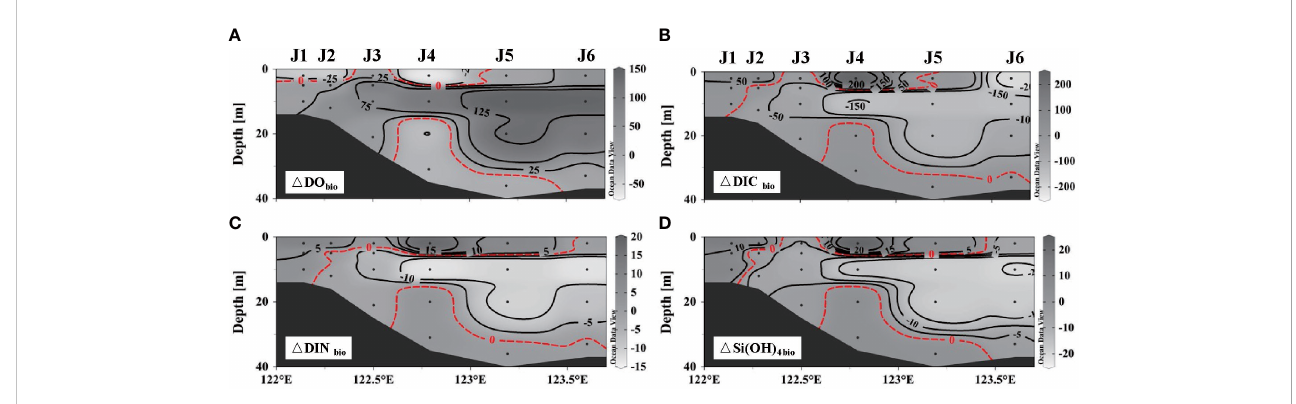
FIGURE 6 Distribution of parameters related to the biological process along section J: (A) dissolved oxygen, (B) dissolved organic carbon, (C) dissolved inorganic nitrogen, and (D) Si(OH)